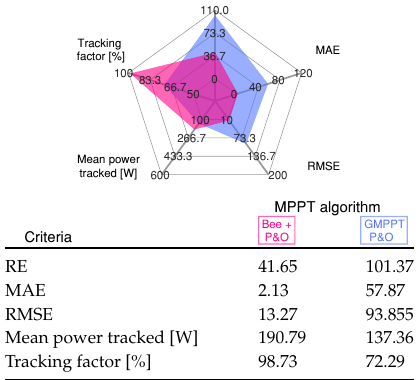
Figure 16. Comparative analysis of the MPPT methods under different nonuniform irradiance conditions for Scenario 5 shown in Figure